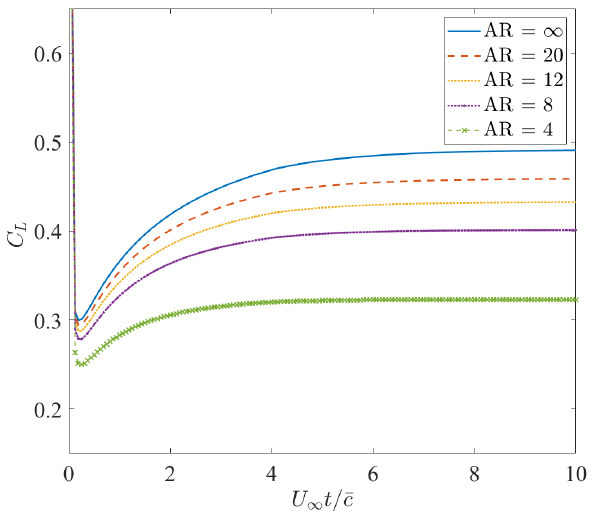
Figure 11. Variations of the transient lift coefficient with